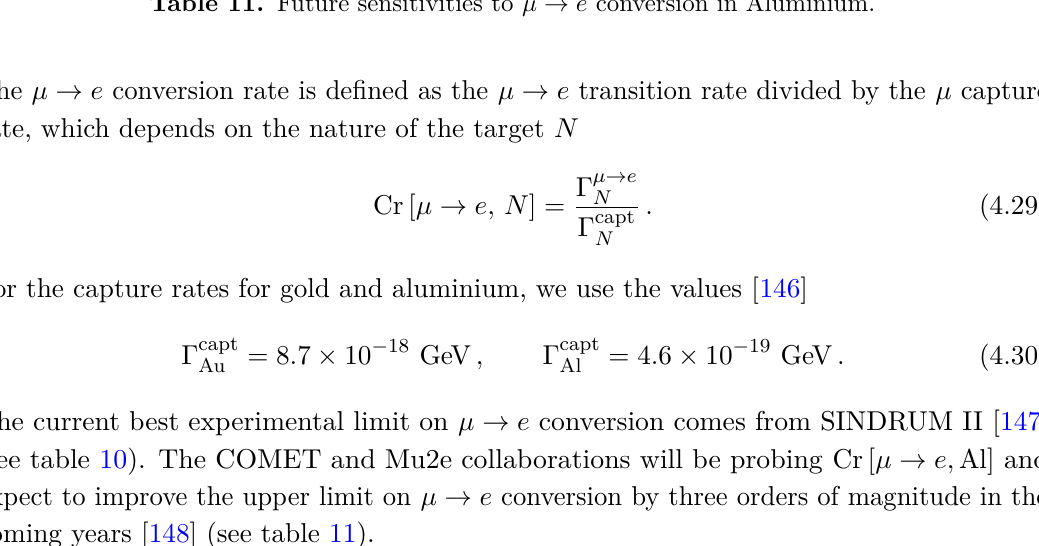
Table 11. Future sensitivities to µ → e conversion in